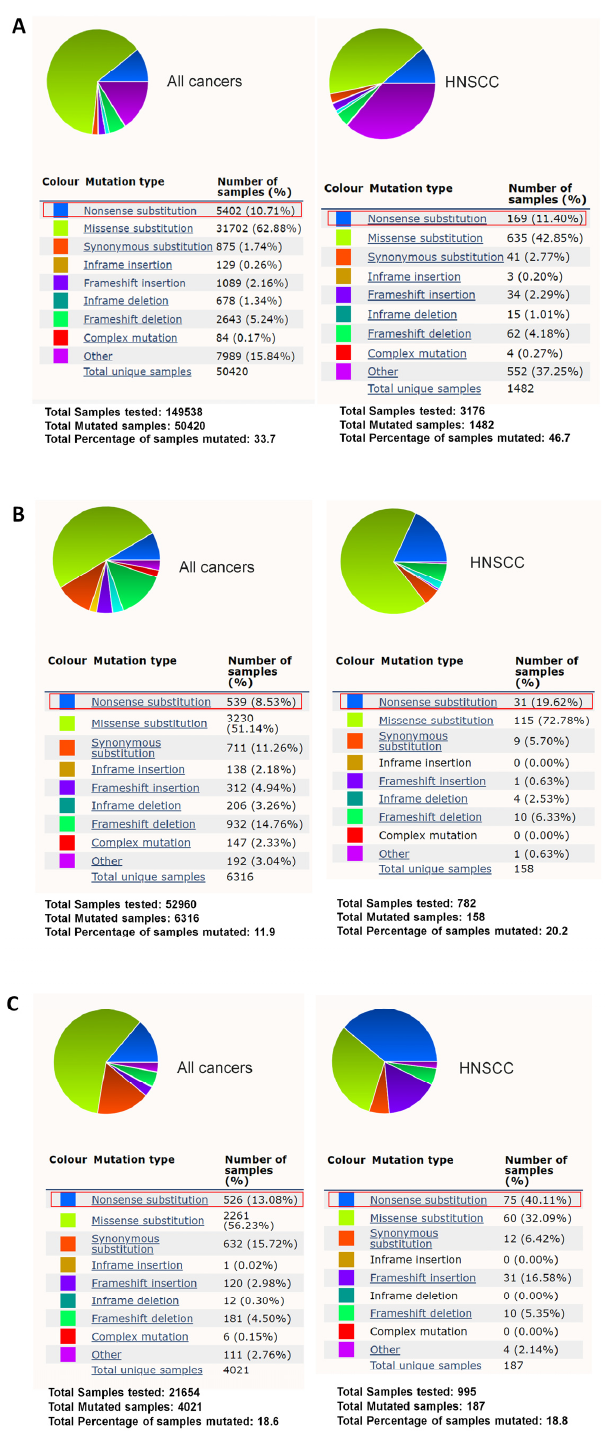
Figure 1. NOTCH1 and FAT1 have a high nonsense mutation rate in HNSCC. ( A ) TP53 has a 10.71% nonsense mutation rate in all the cancer mutation samples and a 11.4% nonsense mutation rate in HNSCC with TP53 mutation in the COSMIC database (https://cancer.sanger.ac.uk/cosmic (accessed on 1 October 2022)) [21]. ( B ) NOTCH1 only has an 8.53% nonsense mutation rate across all the cancer mutation samples but a 19.62% nonsense mutation rate in HNSCC with NOTCH1 mutation in the COSMIC database [21]. ( C ) FAT1 only has a 13.08% nonsense mutation rate across all the cancer mutation samples but a 40.11% nonsense mutation rate in HNSCC with FAT1 mutation in the COSMIC database